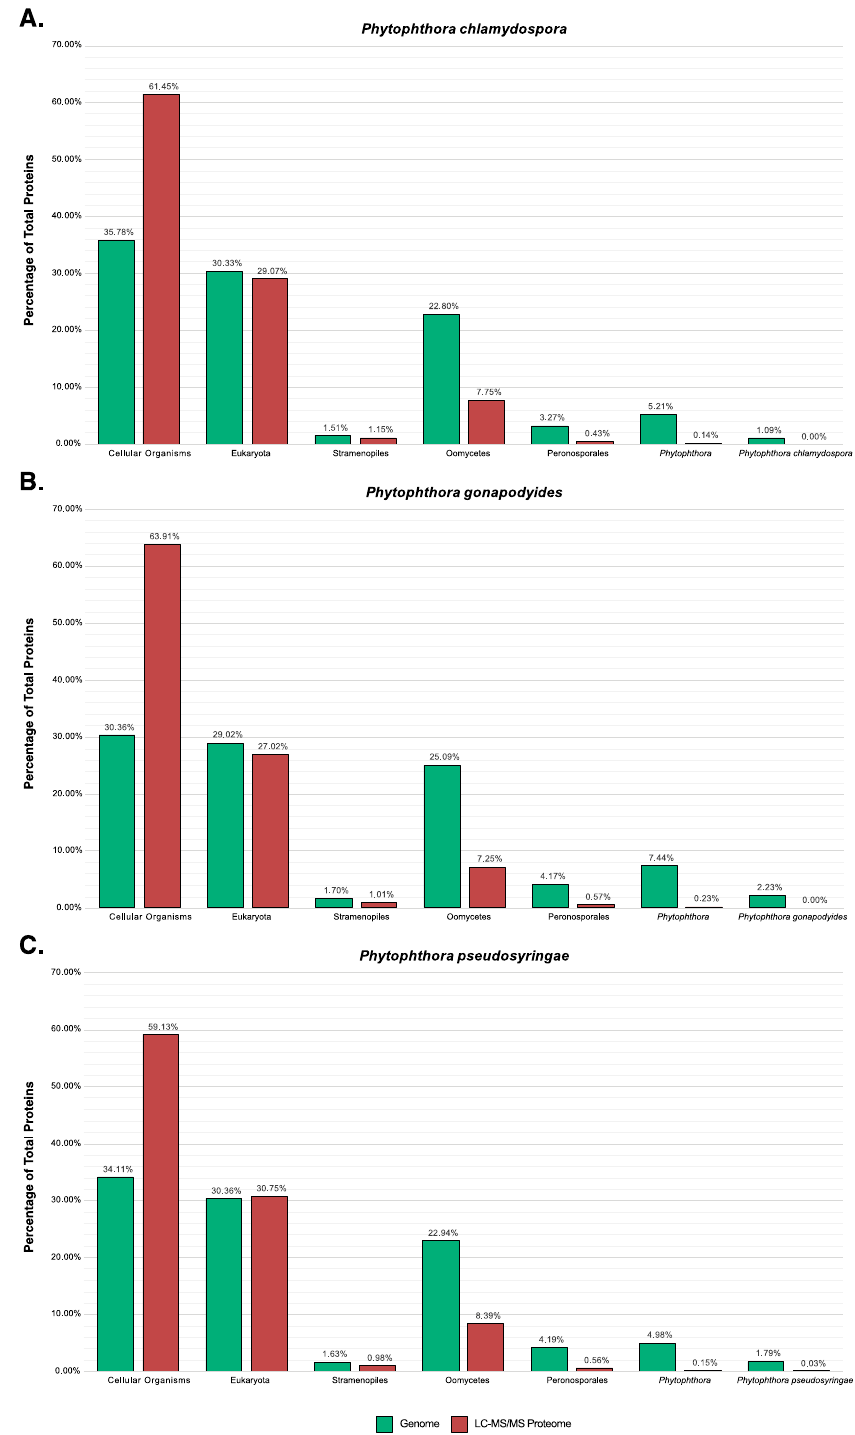
Figure8. Phylostratigraphyanalysisof Ph.chlamydospora ( A ), Ph. gonapodyides ( B ),and Ph.pseudosyringae Figure 8. Phylostratigraphy analysis of Ph. chlamydospora (A) , Ph. gonapodyides (B) , and Ph. ( C ), showing the proportion of genes assigned to each phylostratum for both the genome and the pseudosyringae (C) , showing the proportion of genes assigned to each phylostratum for both the LC-MS / MS genome and the LC-MS/MS proteome.